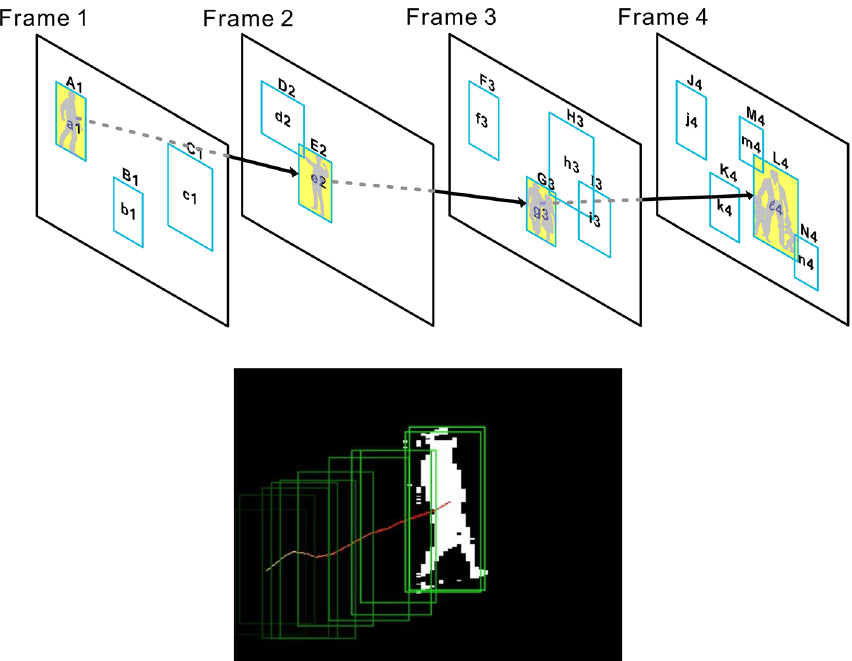
Figure 9. The Viterbi algorithm for finding the most probable human motion sequence. a 1 , e 2 , g 3 , and l 4 represent the computed probabilities that bounding boxes A 1 , E 2 , G 3 , and L 4 have a human presence, respectively. The green boxes in the bottom figure (actual, real human tracking example) represent the bounding boxes in sequence, collected from different frames.